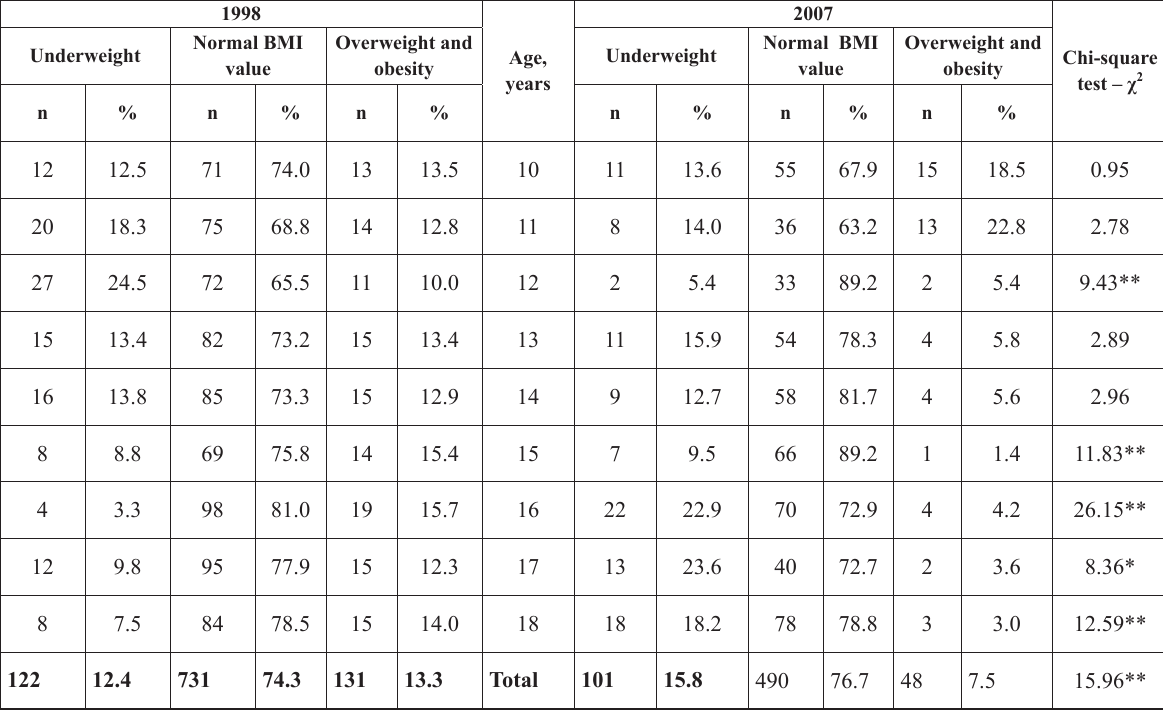
Note. * – statistically signi fi cant differences at the level p < 0.05; ** – statistically signi fi cant differences at the level p <